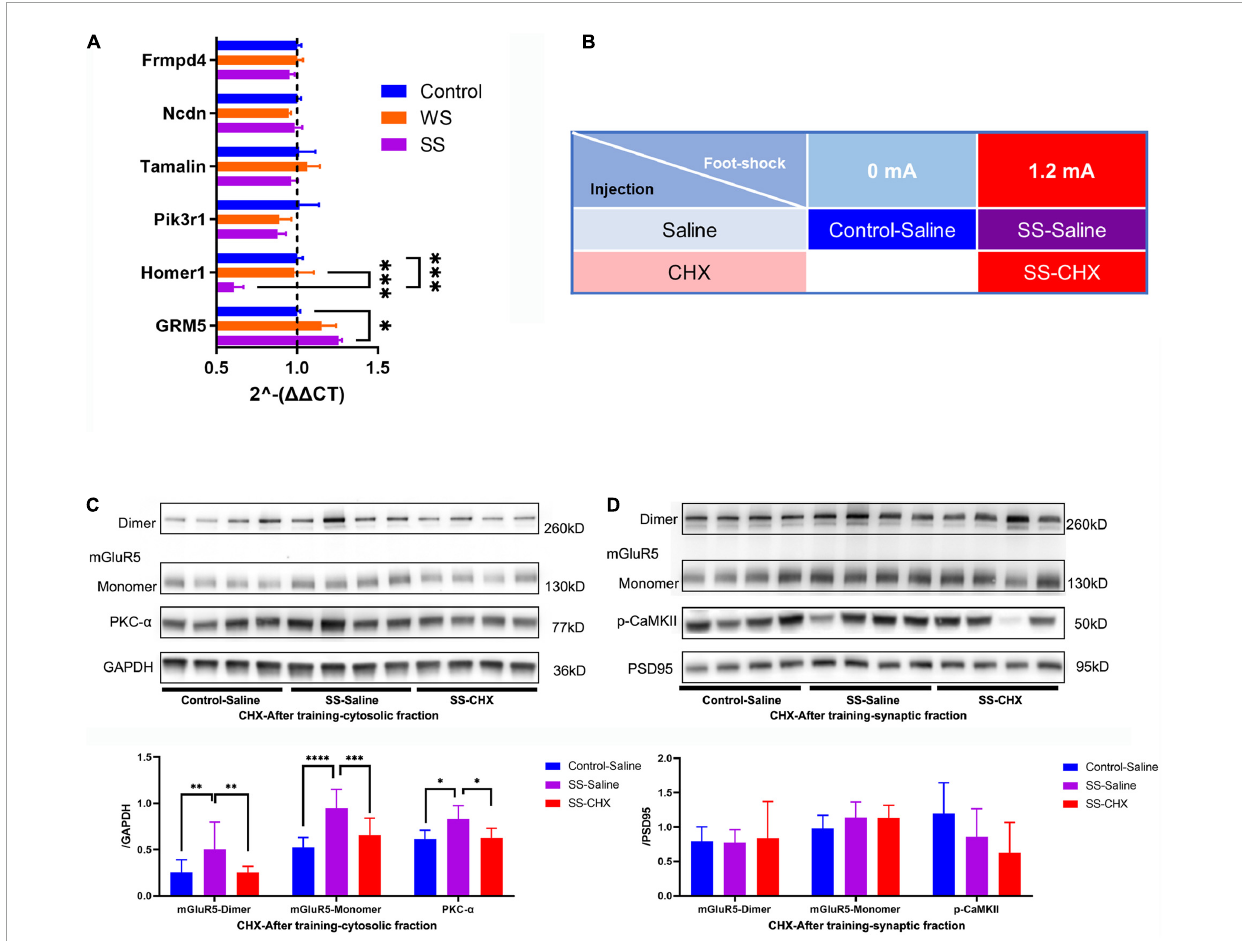
FIGURE5 Increased expression of mGluR5 come from de novo protein synthesis. (A) RT-qPCR analysis of the GRM5, Homer1, Pik3r1, Tamalin, Ncdn and Frmpd4 in the amygdala of mice immediately after CFC training (4 mice in each group, two-way ANOVA, F 10 , 48 = 3.265, p = 0.0027, Tukey’s multiple comparisons test, GRM5, p [ Control vs WS ] = 0.2473, ∗ p [ Control vs SS ] = 0.0225, p [ WS vs SS ] = 0.4480; Homer1, p [ Control vs WS ] = 0.9813, ∗∗∗ p [ Control